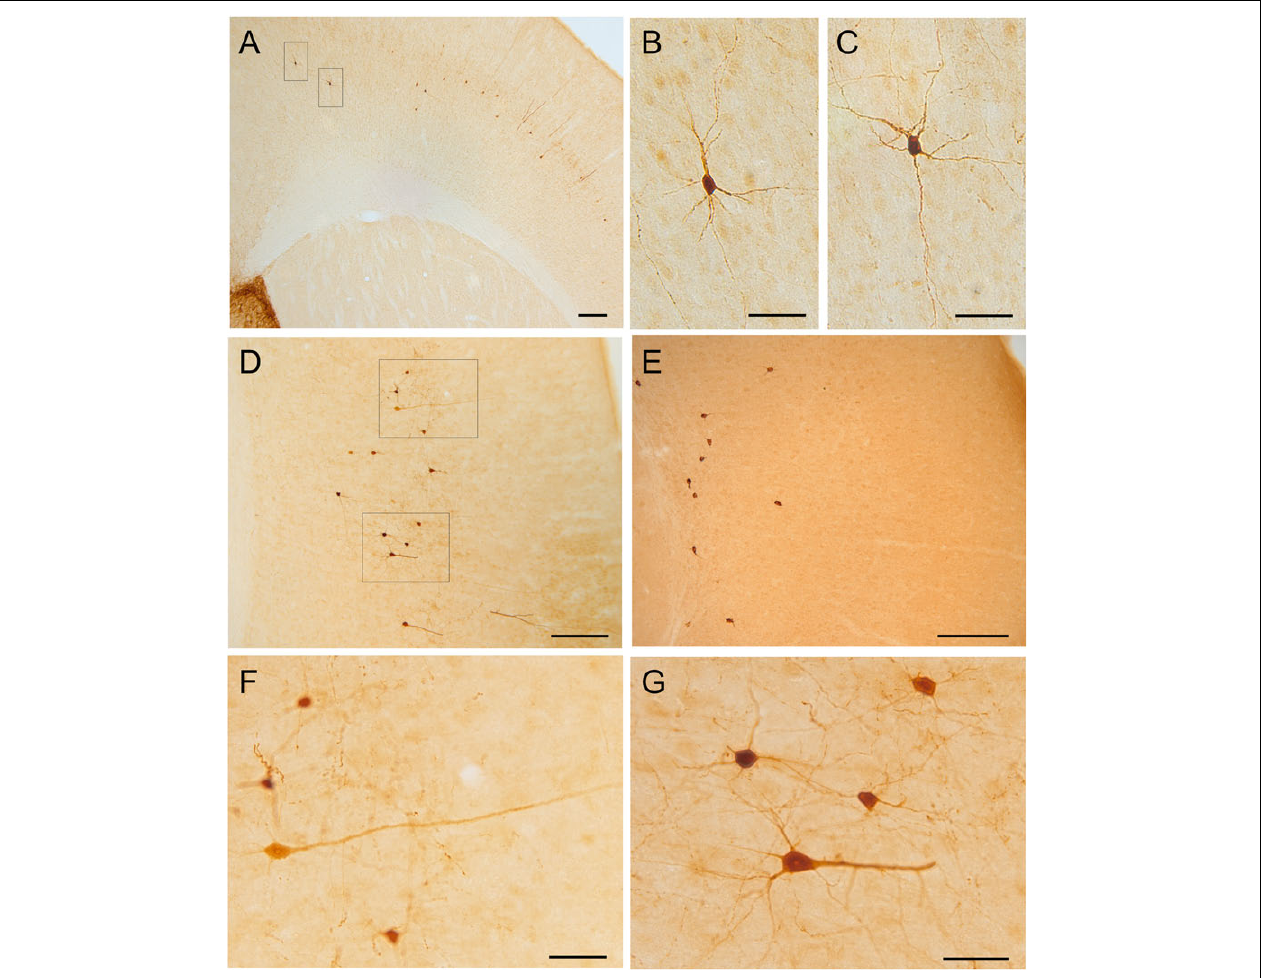
FIGURE 7 | GFP and HA immunoreactivity in the neocortex. Images of frontal brain sections of adult Otp-eGFP mice (A–D,F,G) and Otp-Cre; Rpl22-HA mice (E) , showing GFP or HA immunoreactive cells in the mesocortex and neocortex, from medial to lateral levels. Panel (A) shows the mesocortex and the adjacent medial part of the neocortex, while panels (D,E) show lateral parts of the neocortex (the images were rotated, so that the pial surface is to the right). Details of the cells are displayed in panels (B,C,F,G) , showing their highly heterogeneous morphologies, ranging from large pyramidal like to small multipolar or stellate types. In the Otp-Cre; Rpl22-HA, labeled cells are observed in similar positions of the cortex to those in the Otp-eGFP, but many of them occupy a deeper stratum than those in the Otp-eGFP. See text and abbreviation list for more details. Scale bar: panels (A,D,E) = 200 µ m. Panels (B,C,F,G) = 50 µ